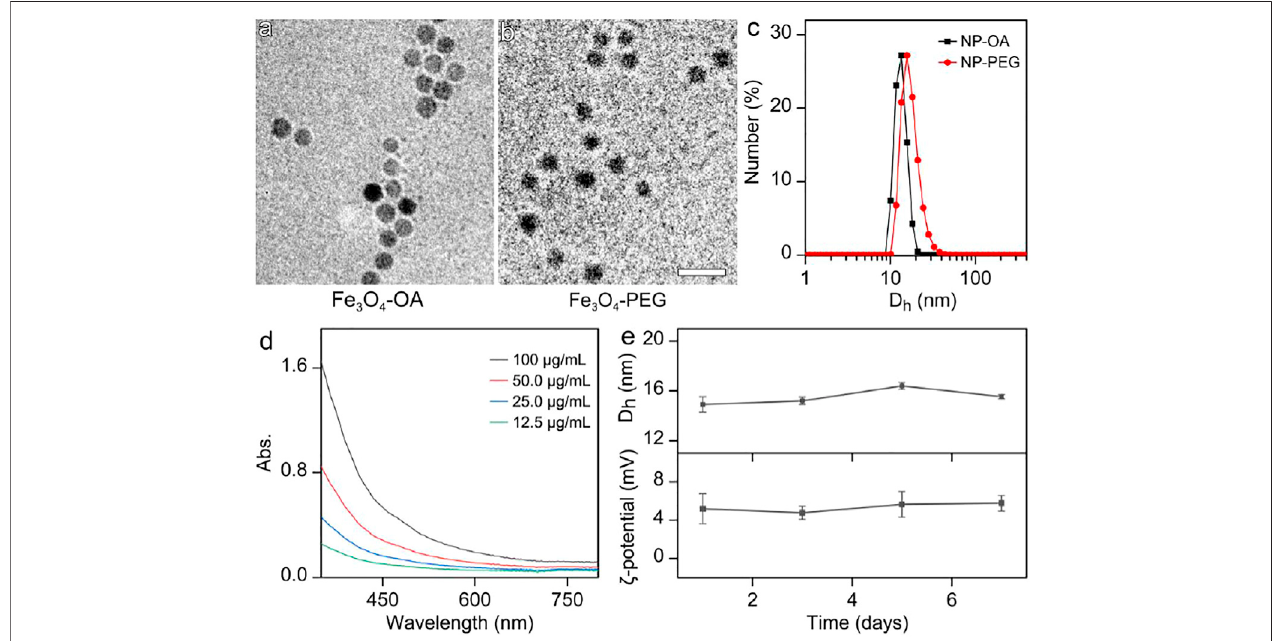
FIGURE1| TEMimagesof (a) OA-cappedFe 3 O 4 nanoparticles(Fe 3 O 4 -OA)and (b) aqueoussolubleFe 3 O 4 nanoparticlesafterligandexchange(Fe 3 O 4 -PEG).(The embedded scalebars correspond to30 nm) (c) D h distributionpro fi les oftheNP-OA nanoparticlesincyclohexanesolutionand NP-PEGnanoparticlesinwatersolution. (d) The UV-Vis absorption spectrum of aqueous solution of PEGyated Fe 3 O 4 nanoparticles. (e) The temporal evolutions of D h and zeta potential of the nanoparticles in water, for showing the colloidal stability of particles.